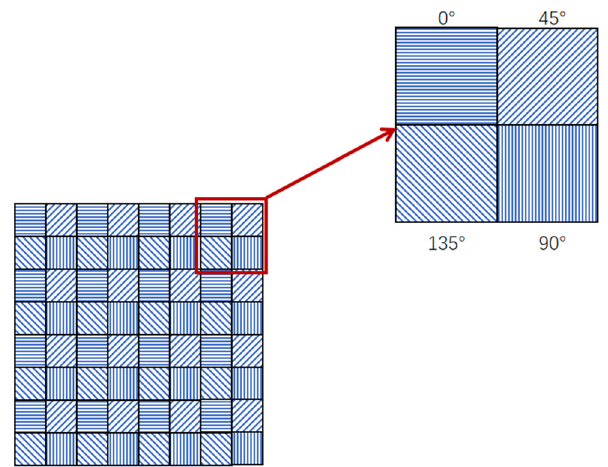
Figure 1. Schematic diagram of the micro-polarizer array system.